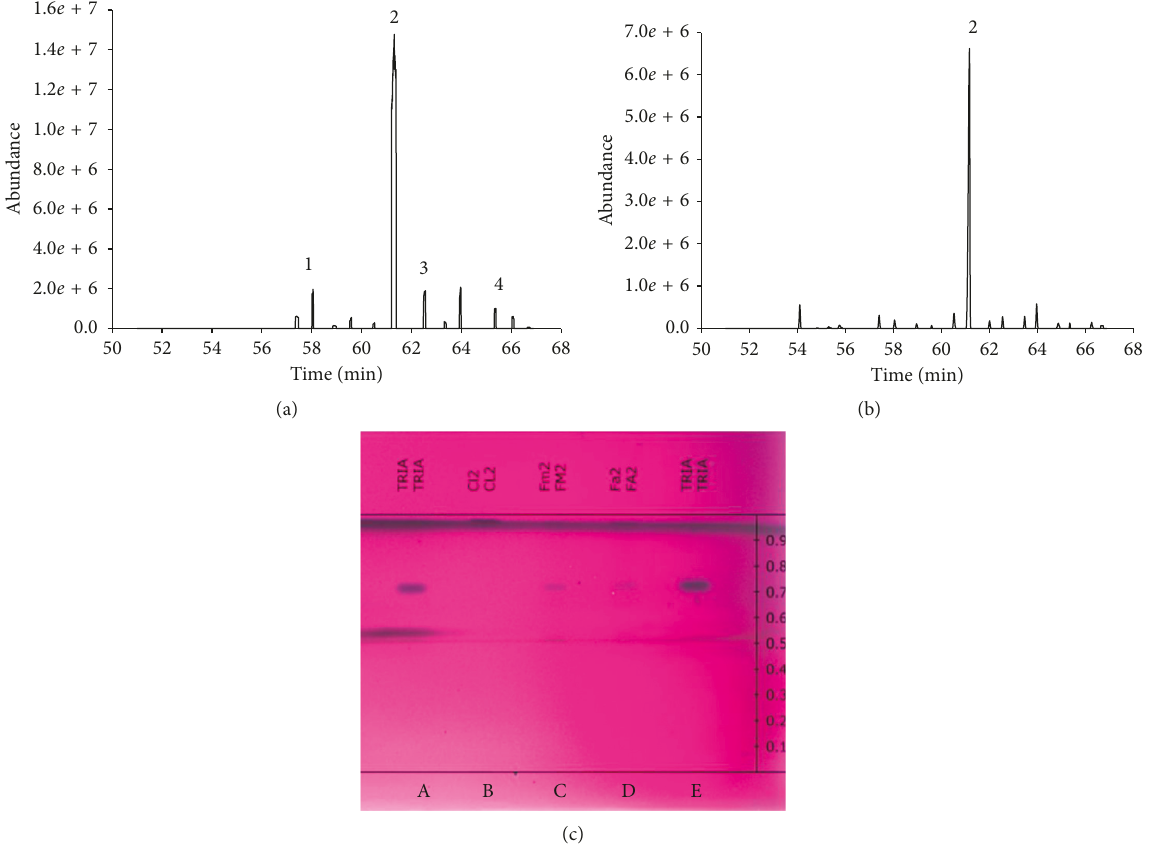
Figure 2: HPTLC chromatoplate: lanes A and E correspond to the triacontanol standard (Rf 0.73); lane B corresponds to the purified wax obtained by extraction with cyclohexane and cleaning with methanol and acetone; lane C is the methanolic fraction; and lane D is the acetonic fraction. Chromatograms of methanolic (a) and acetonic (b) fractions: peaks corresponding to 1, octacosanol; 2, triacontanol; 3, untriacontanol; and 4,